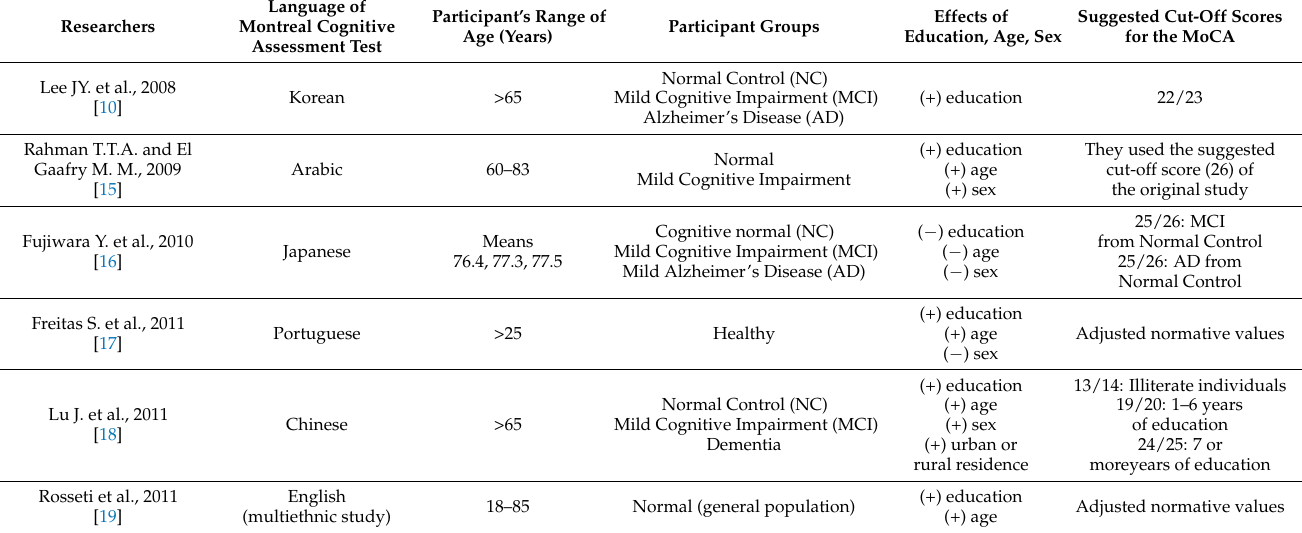
Table 1. Overview of international studies on normative data (listed by year of